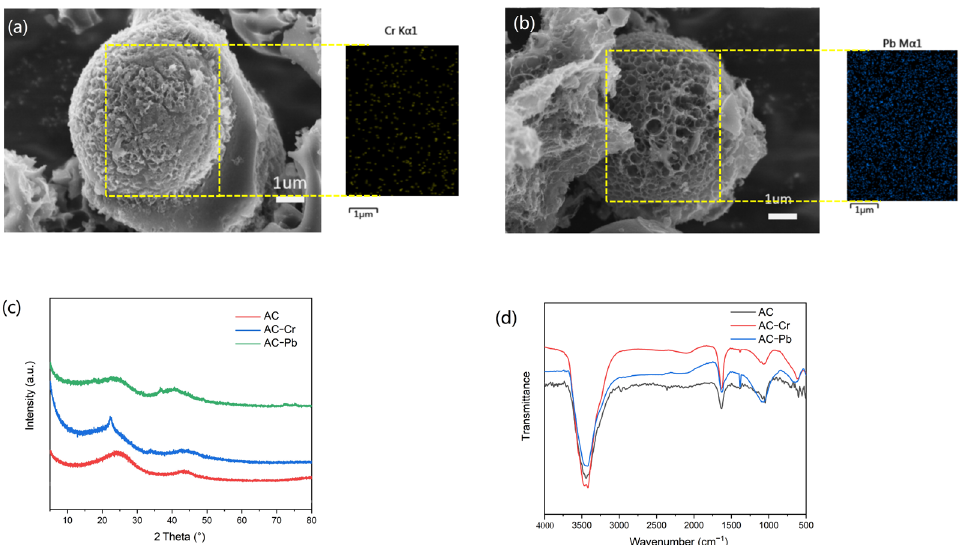
Figure 4. ( a , b ) The SEM image and heavy metal distribution image of the AC sample after Cr(VI) ( a ) and Pb(II) ( b ) adsorption; ( c ) the PXRD patterns of AC before and after Cr(VI) and Pb(II) adsorption; ( d ) the IR spectra of AC before and after Cr(VI) and Pb(II) adsorption. The adsorption samples were obtained in 100 mg · L − 1 heavy metal solution with an adsorbent dosage of 7 g · L − 1 for 12 h.